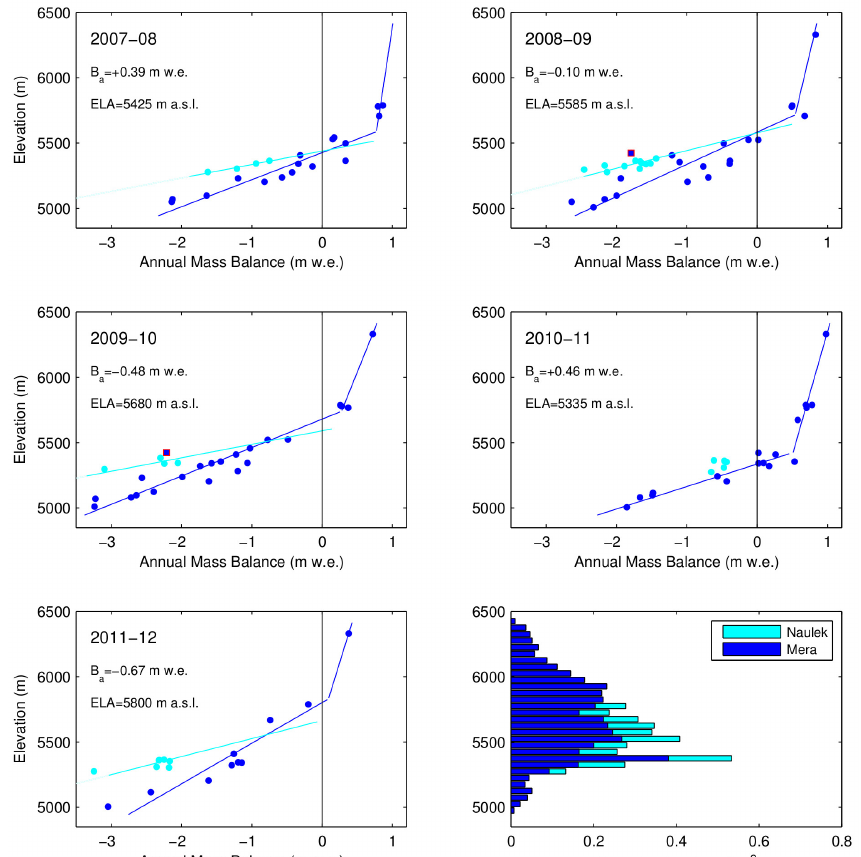
Fig. 5. Five first panels: five years of annual point mass balance (dots) as a function of altitude derived from field measurements (stakes, drillings or pits) on Mera Glacier. Measurements were performed on 17 November 2007, 6 November 2008, 5 November 2009, 11 November 2010, 10 November 2011 and 23 November 2012 ± 4 days. Dark blue is used for the Mera branch, light blue for Naulek. The measurement on Mera in 2008–2009 and 2009–2010 displayed as a blue square highlighted with a red contour refer to the same stake facing northeast. Also shown are the linear regression lines used to derive the annual glacier-wide mass balance B a (point mass-balance measurements above (below) 5600ma.s.l. are used to derive the mass balance gradient over the accumulation (ablation) area except in 2011–2012). In 2010–2011, there were not enough measurements on Naulek branch to derive a significant regression line, and therefore the mean vertical mass balance gradient obtained over the four other years on Naulek was used instead, i.e. 0.85mw.e. (100m) − 1 . In 2011–2012, point mass balance data measured at 5790 and 5670ma.s.l. were exceptionally negative and thus used to derive the linear regression line over the ablation area, the upper regression line being chosen equal to the mean vertical mass balance gradient obtained over the four previous years in the accumulation area, i.e. 0.06mw.e. (100m) − 1 . B a and ELA for every year are displayed on the corresponding panel. Bottom right panel: hypsometry of Mera Glacier showing the respective areas of Naulek (light blue) and Mera (dark blue)